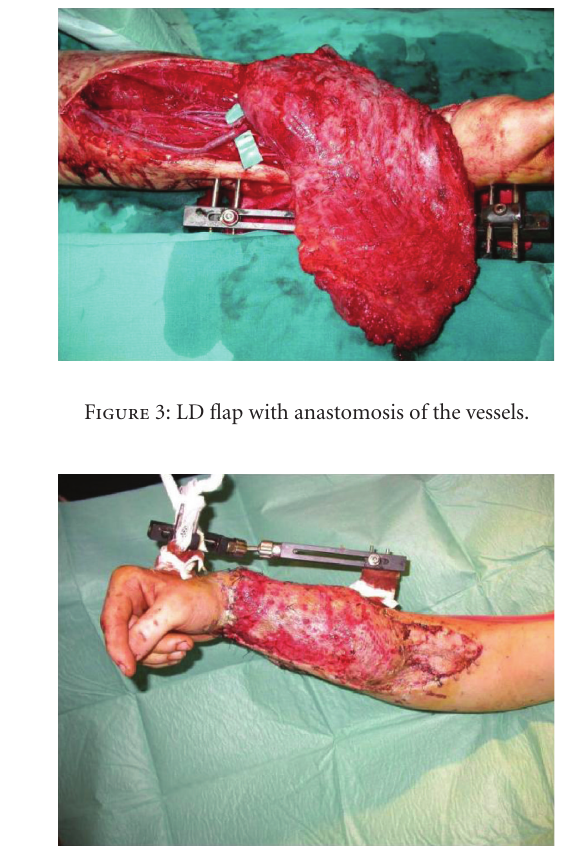
Figure 2: Intraoperative external and intramedullary fixations.